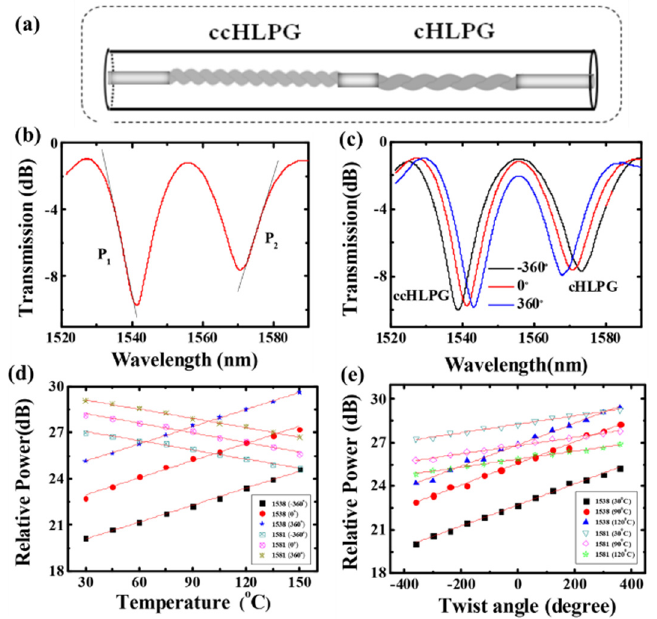
Figure 19. ( a ) Structures of the two-cascaded HLPGs-based sensors, ( b ) principle of the power-integrated measurement method, ( c ) transmission spectra under different torsions, ( d ) changes of the output power as function of the temperatures, and ( e ) change of the output power as function of the applied torsional angles. Adapted with permission from Ref. [13] © The Optical Society.